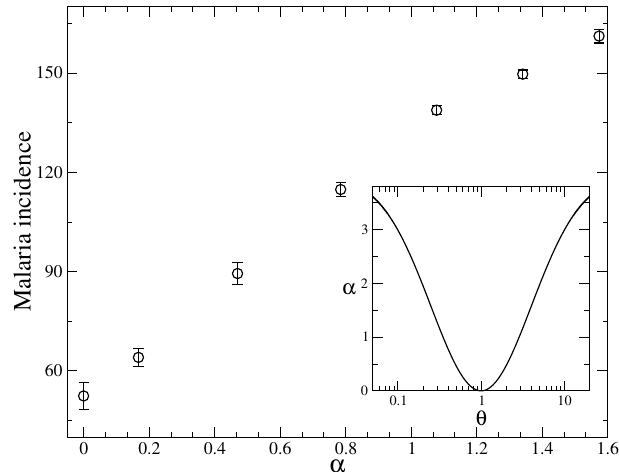
Figure 2. Malaria incidence as a function of heterogeneous affinity α as defined in Equation (3). The inset shows the change in heterogeneous affinity with θ , as defined in Equation